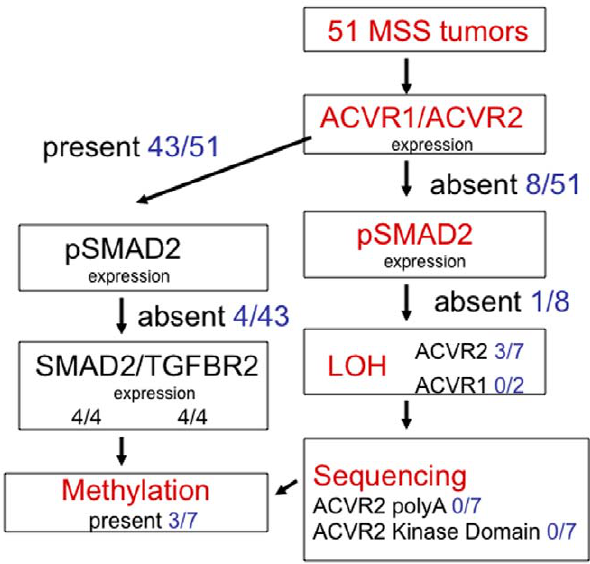
Figure 2. Summary of ACVR2 loss and its mechanisms in primary MSS colon cancer specimens. Of the 51 MSS colon cancers